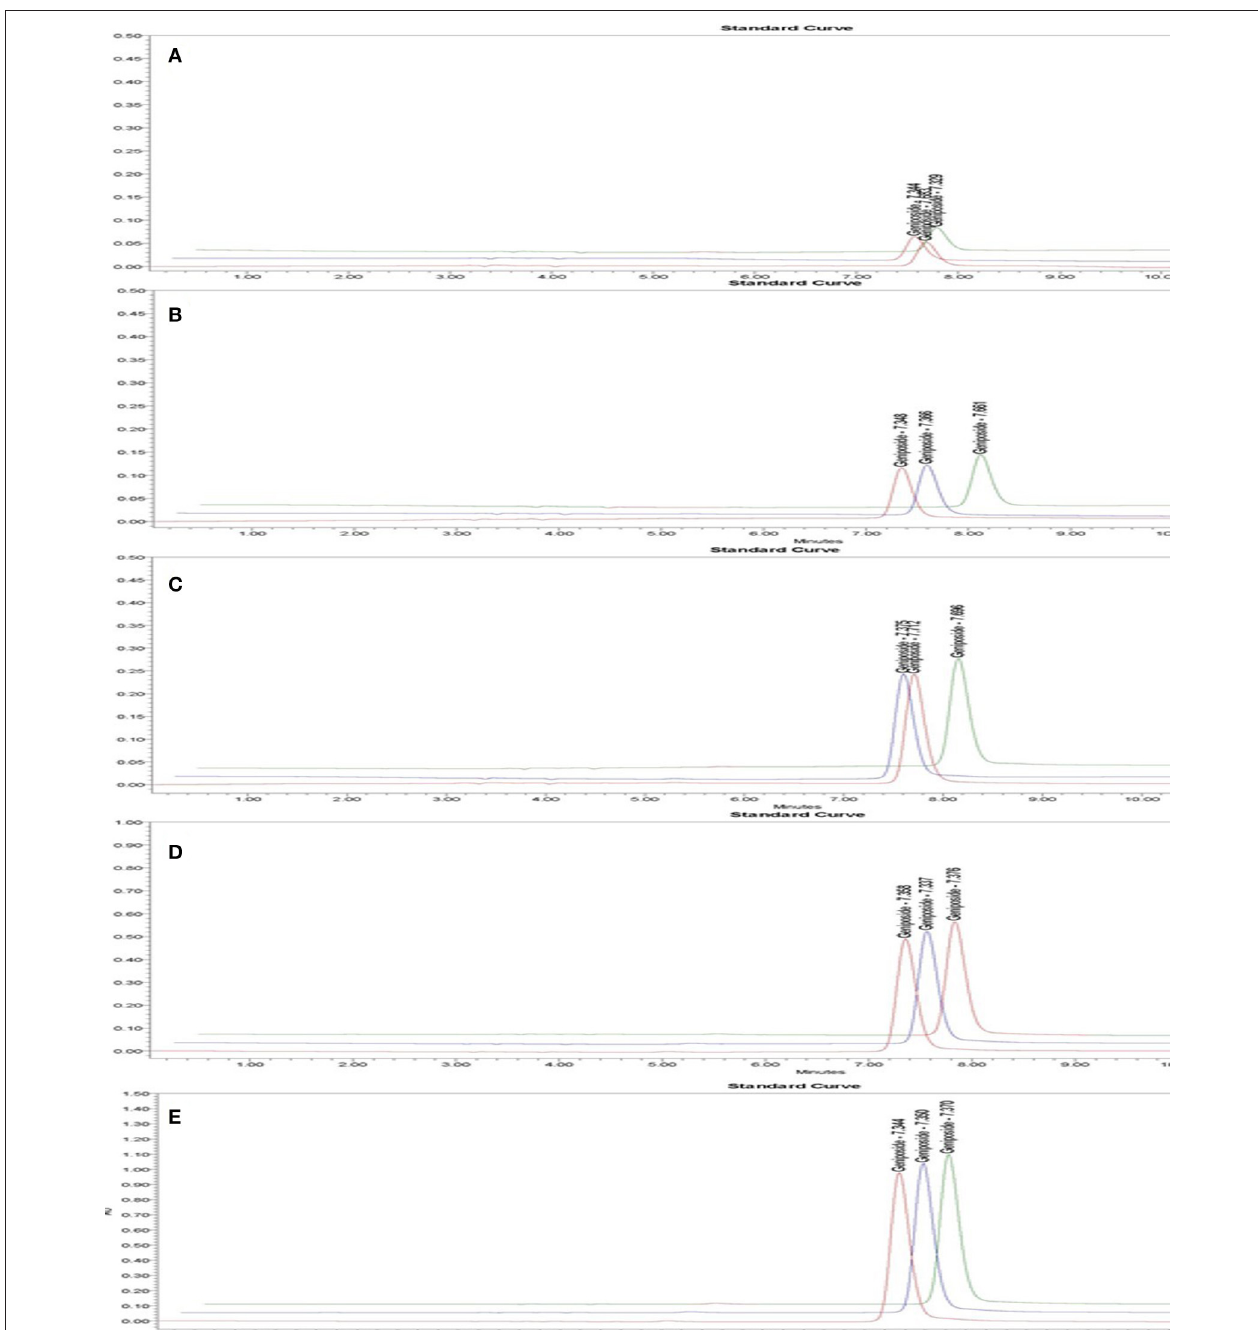
FIGURE 5 | HPLC chromatogram of geniposide in standard solution with different geniposide concentrations. Time (min) as unit of Y-axis and chromatographic profiles are reported at 240nm. The concentration of standard solution was 0.0625 mg/mL (A) , 0.125 mg/mL (B) , 0.25 mg/mL (C) , 0.5 mg/mL (D) , 1 mg/mL (E) . were used to find the active components of GJE (Lu et al.,